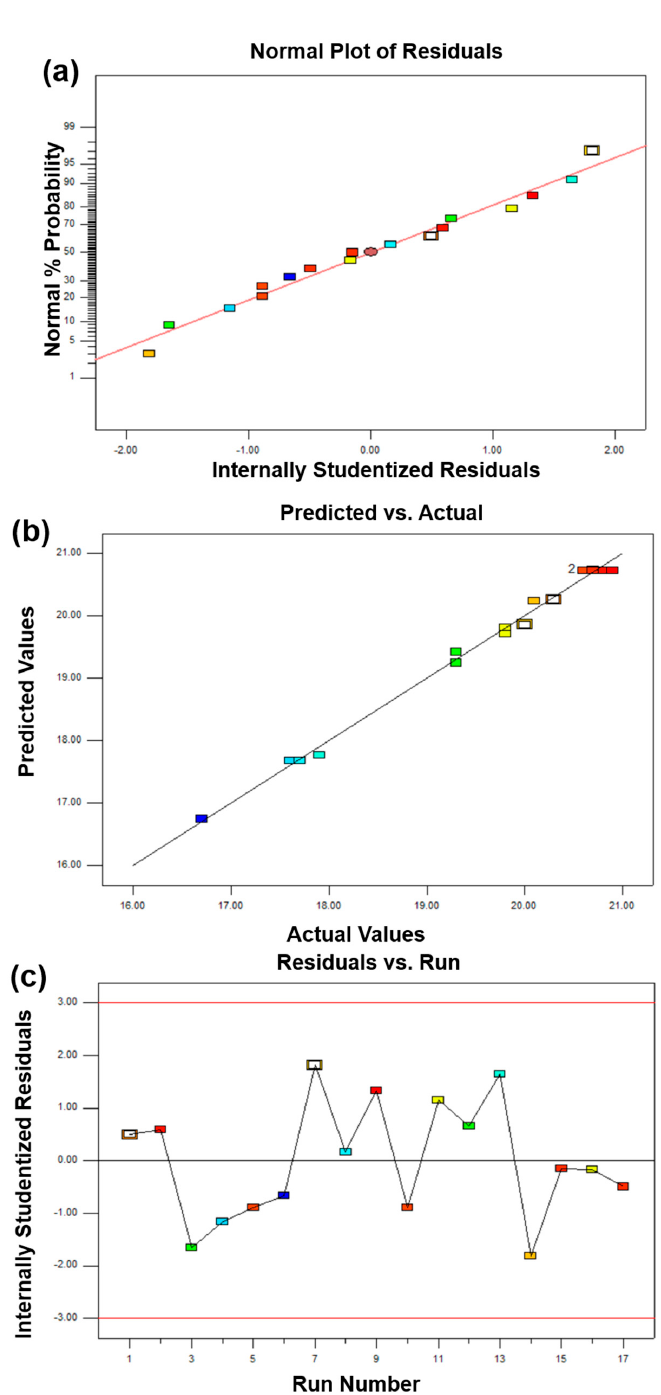
Figure 4. The adequacy of diagnostic maps of the abrasive ratio BBD model: ( a ) comparison of normal probability with internal studentized residuals, ( b ) comparison between actual and predicted values, and ( c ) internally studentized of each experimental point.